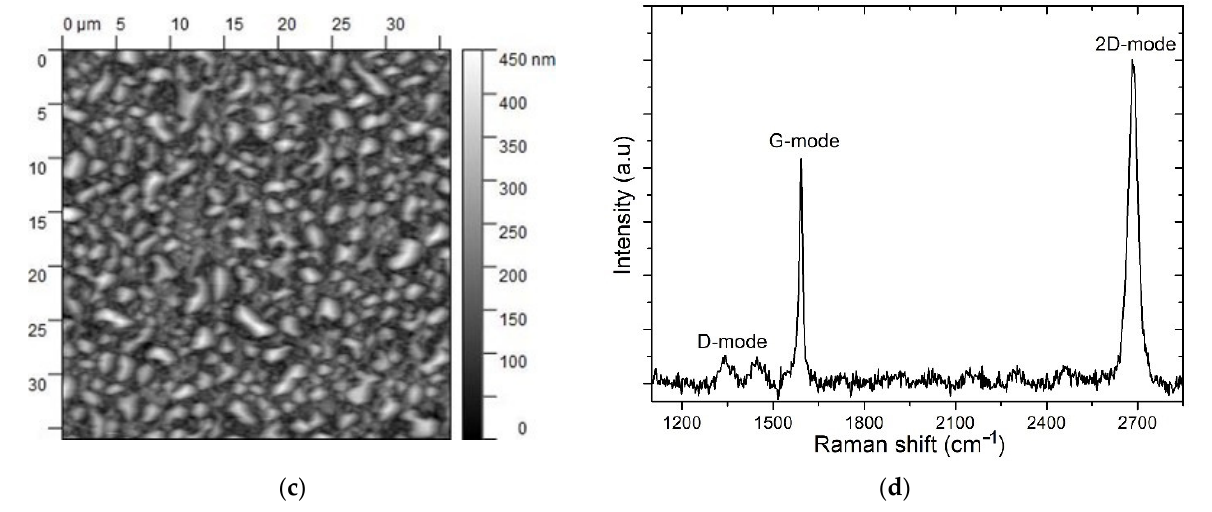
Figure 3. ( a , b ) SEM images of patterned SiO 2 /gold diffraction grating, where ( b ) demonstrates the groove interface. ( c ) AFM of the plane SiO 2 surface covered with gold. ( d ) Raman spectra of CVD graphene used for metasurface fabrication. Table 1. The metasurface geometrical parameters.